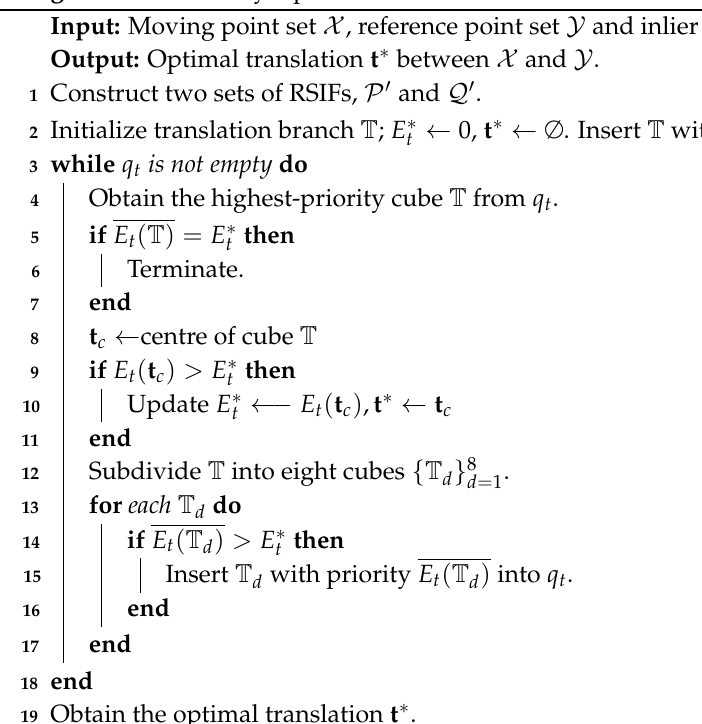
Algorithm 1: Globally Optimal Translation Search Based on